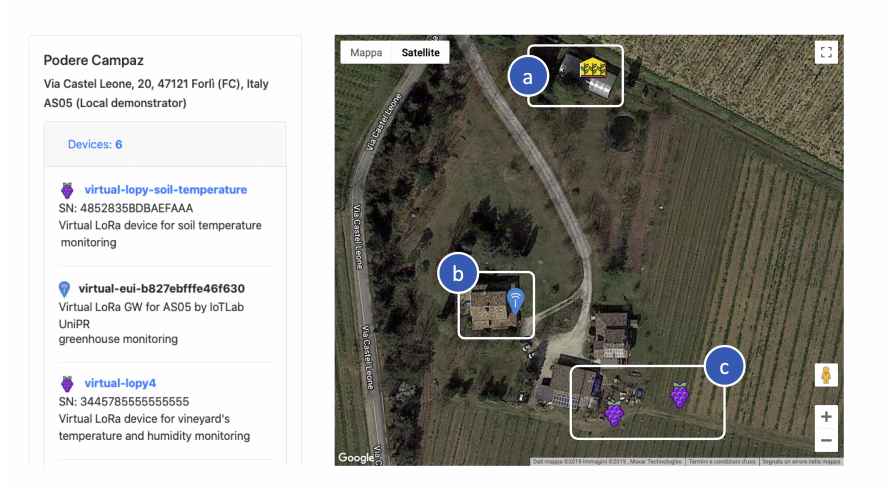
Figure 11. The website homepage displaying the deployed nodes and their location in the farm: ( a ) two INs and a mpGW in the greenhouse; ( b ) the LoRaWAN Gateway; and ( c ) two ENs in the vineyard.